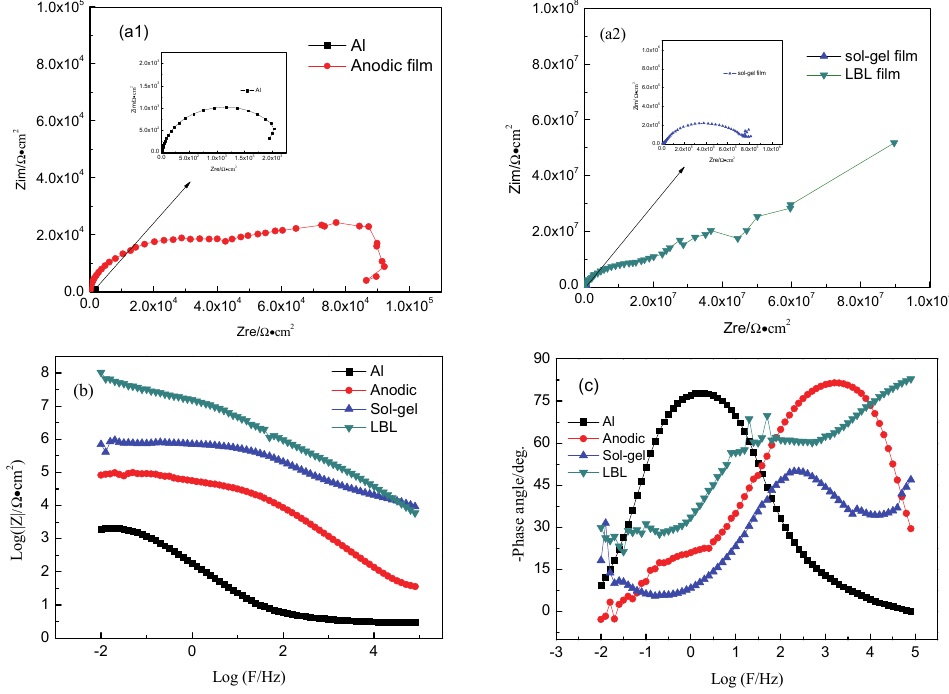
Figure 6. Electrochemical impedance spectroscopy plots and the fitting curves of Al alloy samples with different film. ( a1 ) and ( a2 ) Nyquist plots; ( b ) and ( c ) Bode plots.